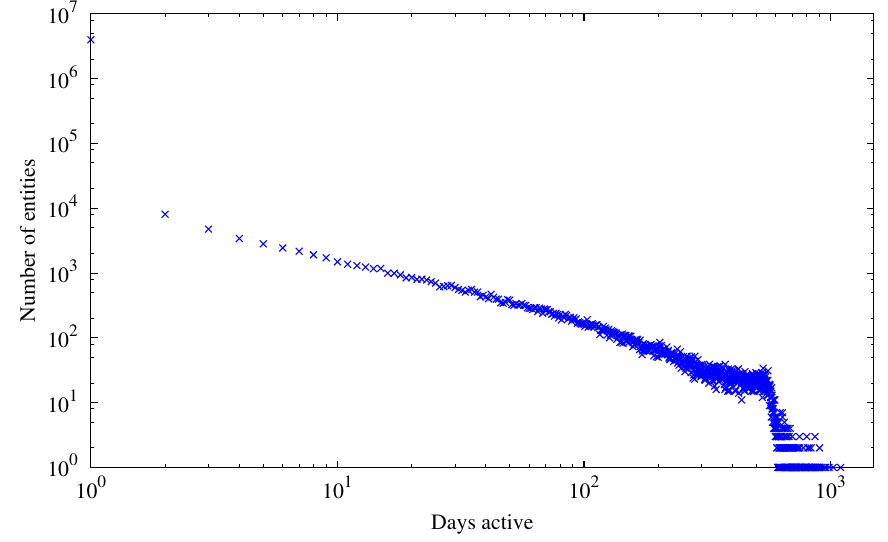
Figure 5. Total number of entities active for a given amount of